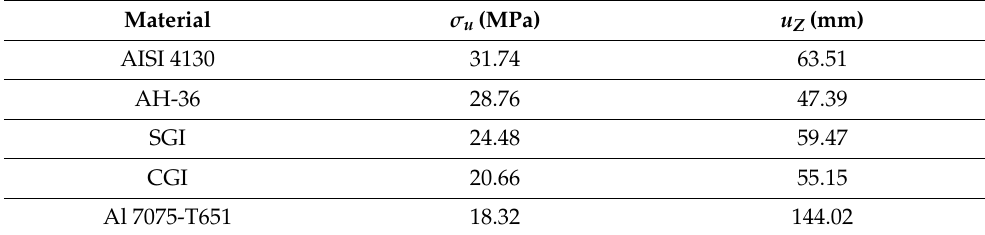
Table 12. Ultimate biaxial buckling stress and maximum deflection of the case study.